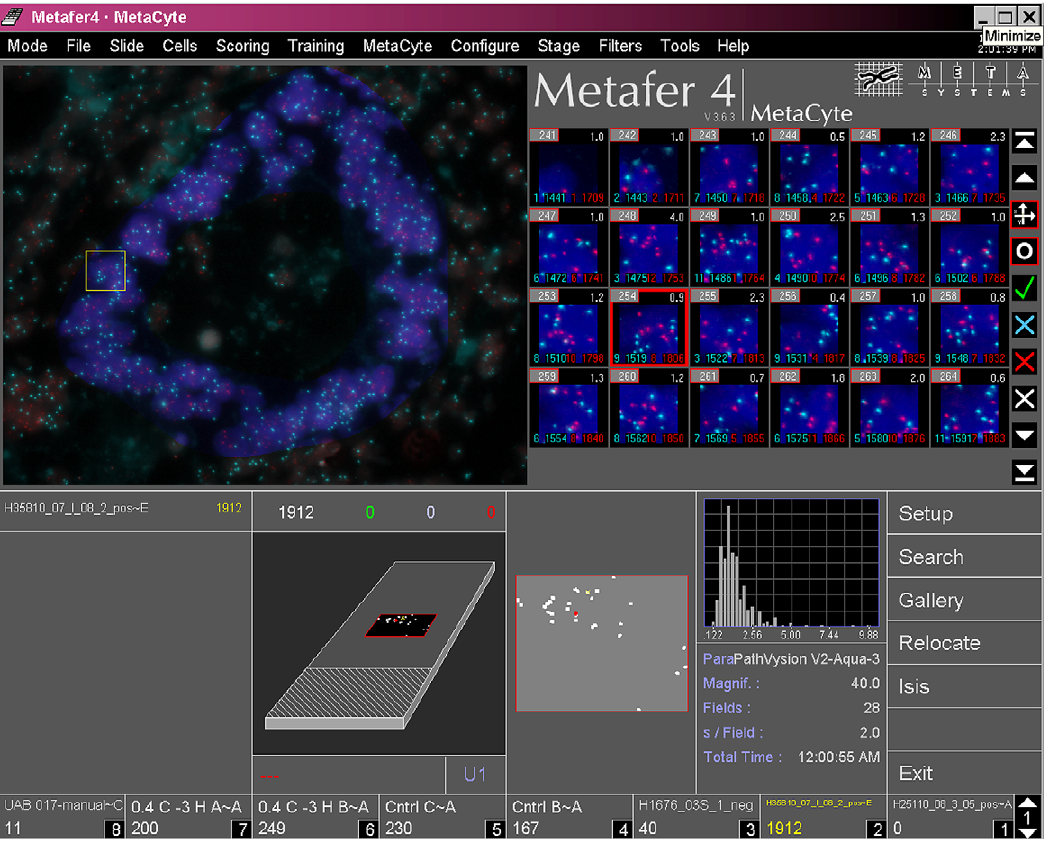
Fig. 3. Screen capture of image analysis. The gallery (upper right) shows “tile sampling” images generated from image upper left (same image as shown in Fig. 2B). The lower part shows relocation data and enumeration histogram. The highlighted gallery image (red box) can be found back in the overview picture (yellow